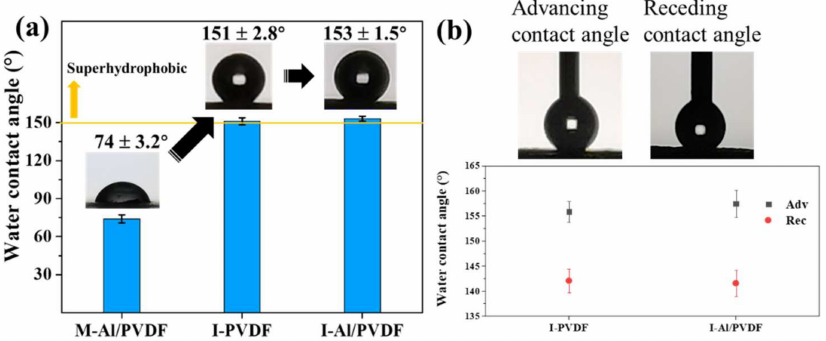
Figure 3. ( a ) The static water contact angle and ( b ) advancing/receding angles of each